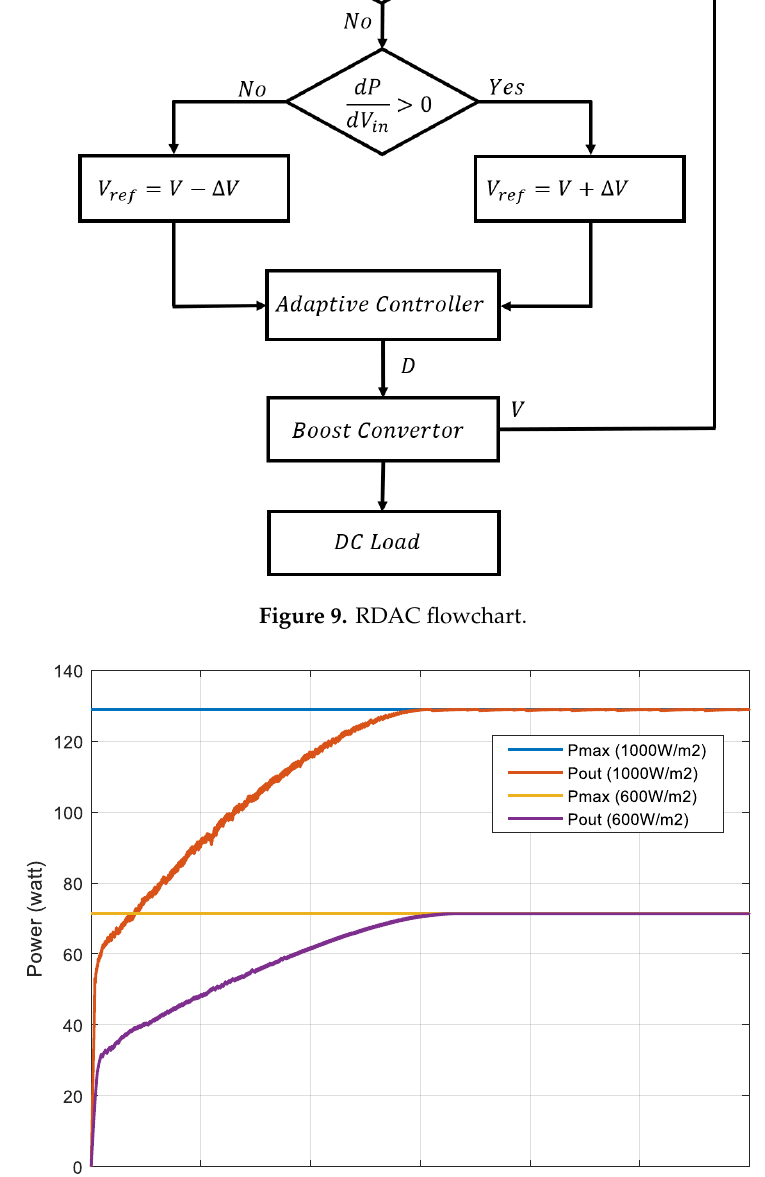
Figure 10. Output power ( P out ) vs. MPP. ( P max ) for fixed 1000 W / m 2 and 600 W / m 2 at 25 ◦ C and Figure 10. Output power (P out ) vs. MPP. (P max ) for fixed 1000 W/m 2 and 600 W/m 2 at 25 C ° and R = R = 15 Ω 15 Ω .